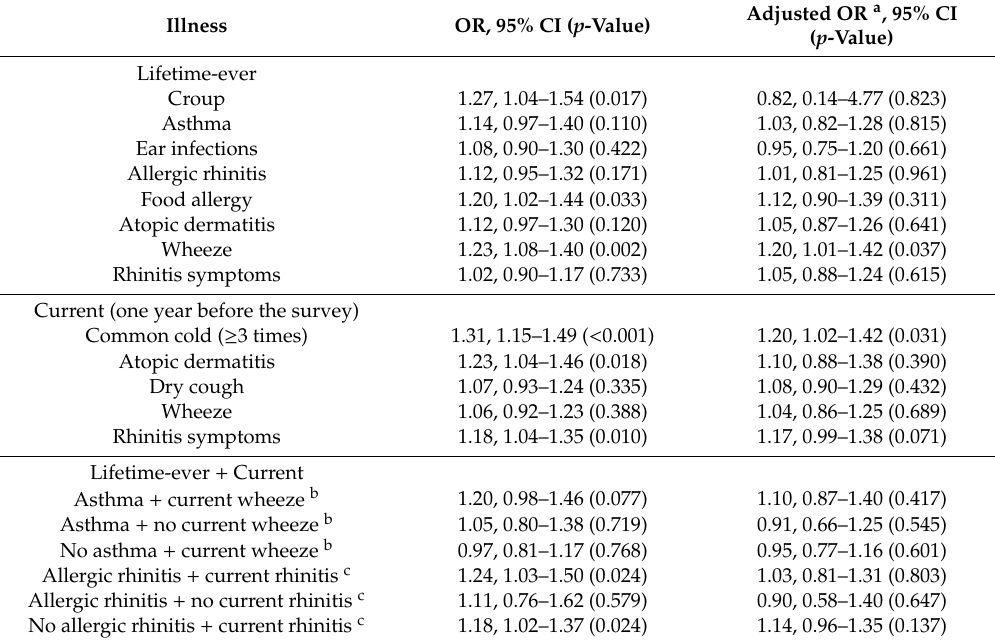
Table 4. Associations between first-year antibiotics exposure and childhood asthma, allergies, and airway illnesses, among children with lifetime-ever pneumonia.